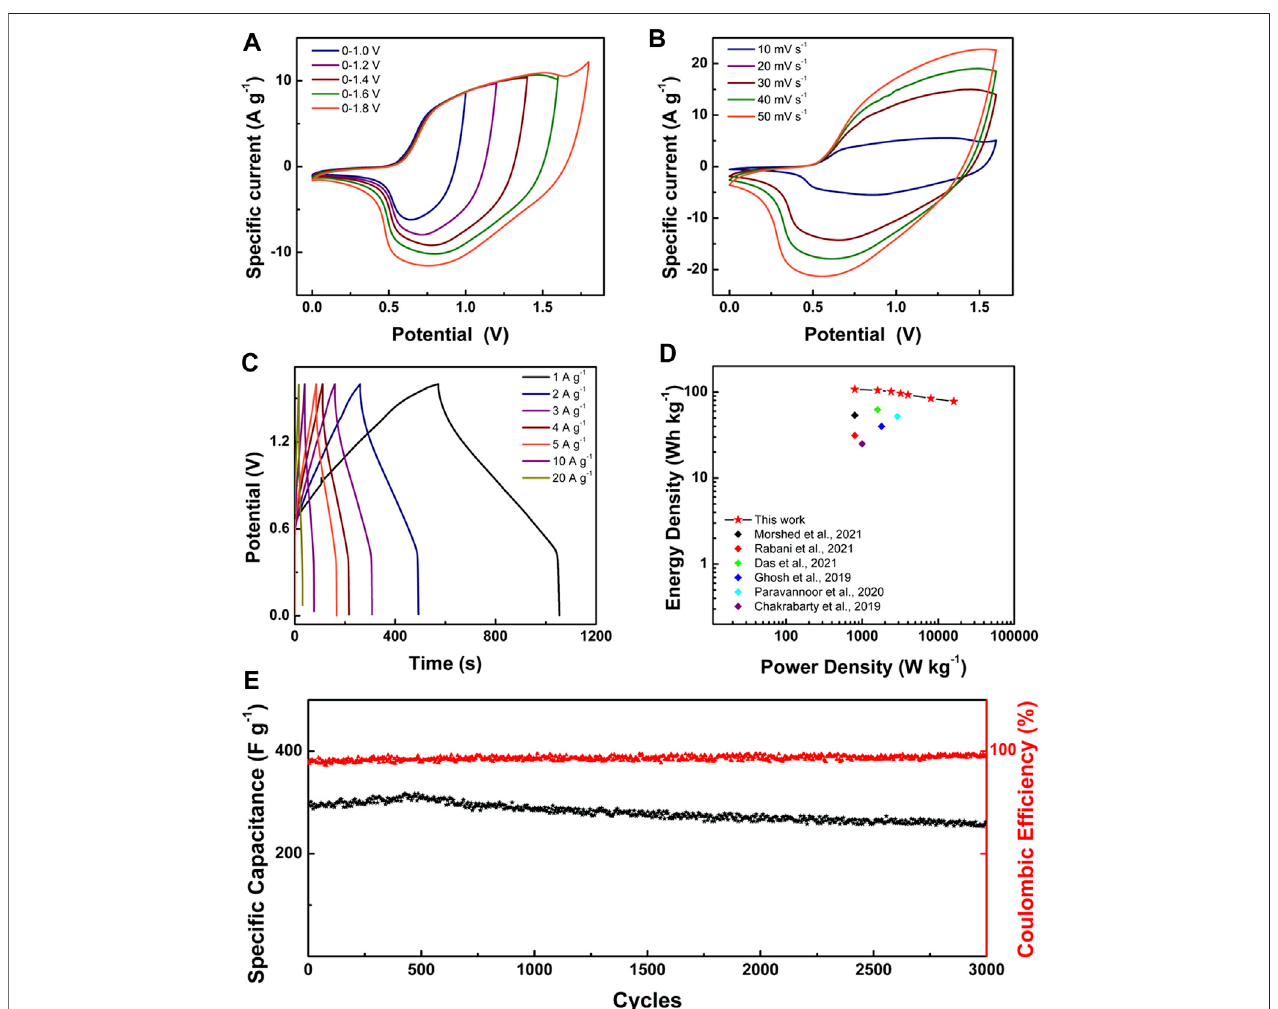
FIGURE 5 | (A) CV curves at scan rate of 20 mV s − 1 of LONH//AC at voltage windows of 0 – 1.0 to 0 – 1.8 V in 3.0 M KOH; (B) CV curves at scan rates of 10 – 50 mV s − 1 ofLONH//ACatavoltagewindowof0 – 1.6 V; (C) GCDcurvesofLONH//ACwithcurrentdensitiesof1.0 – 20.0 A g − 1 ; (D) RagoneplotsofLONH//ACand other reported asymmetric supercapacitors; (E) speci fi c capacitance and Coulombic ef fi ciency of LONH//AC during charge – discharge cycling test at 2.0 A g − 1 .